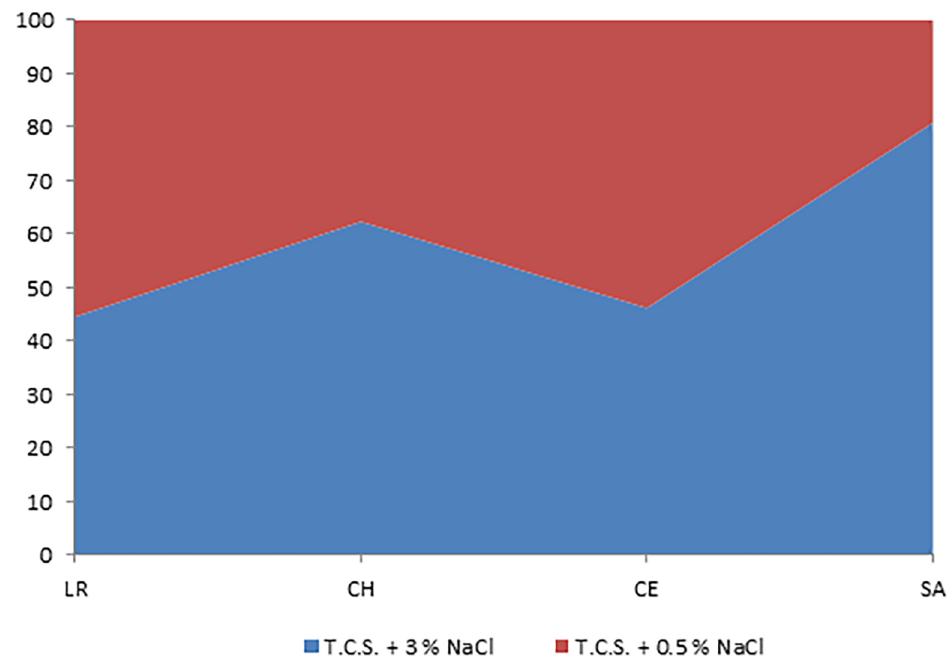
Fig 2. Halophilicity of Vibrio species in the four coastal lagoons analyzed: Rosada lagoon (LR); Chelem (CH); Celestun (CE) and Sabancuy (SA). + NaCl (T.C.S. broth + 3% NaCl); — NaCl (T.C.S.). % of OUT ’ s is referred to the total number of OTU´s classified within the genus Vibrio for each lagoon